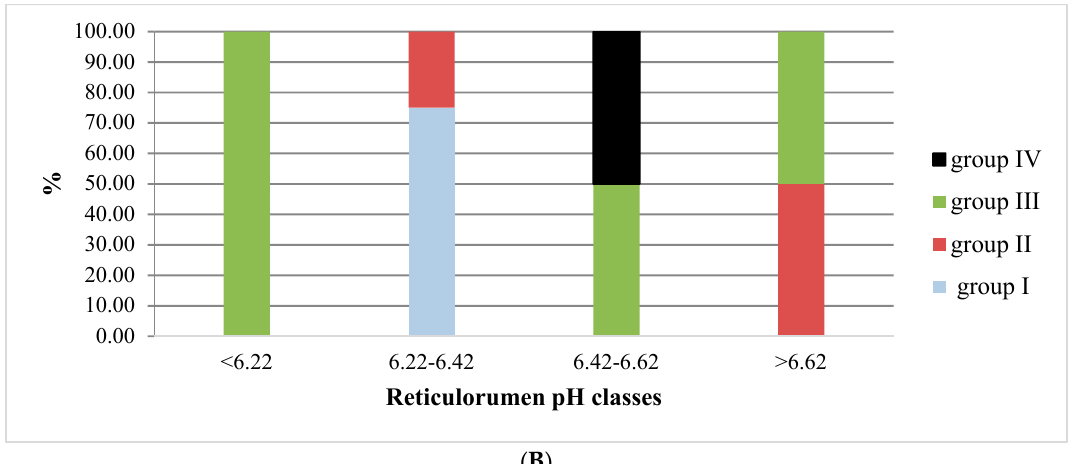
Figure 1. ( A ). Analysis of reticuloromenreticulorumen pH in cows by reproduction status. Group I: 15–30 days postpartum, Group II: 1–34 days after insemination, Group III: 35 days after insemination (non ‐ pregnant), Group IV: 35 days after insemination (pregnant). ( B ). Analysis of reticulorumen pH in cows by status of reproduction. Class 1: pH < 6.22, Class 2: pH 6.22—6.42, Class 3: pH 6.42—6.62, and Class 4: pH > 6.62.